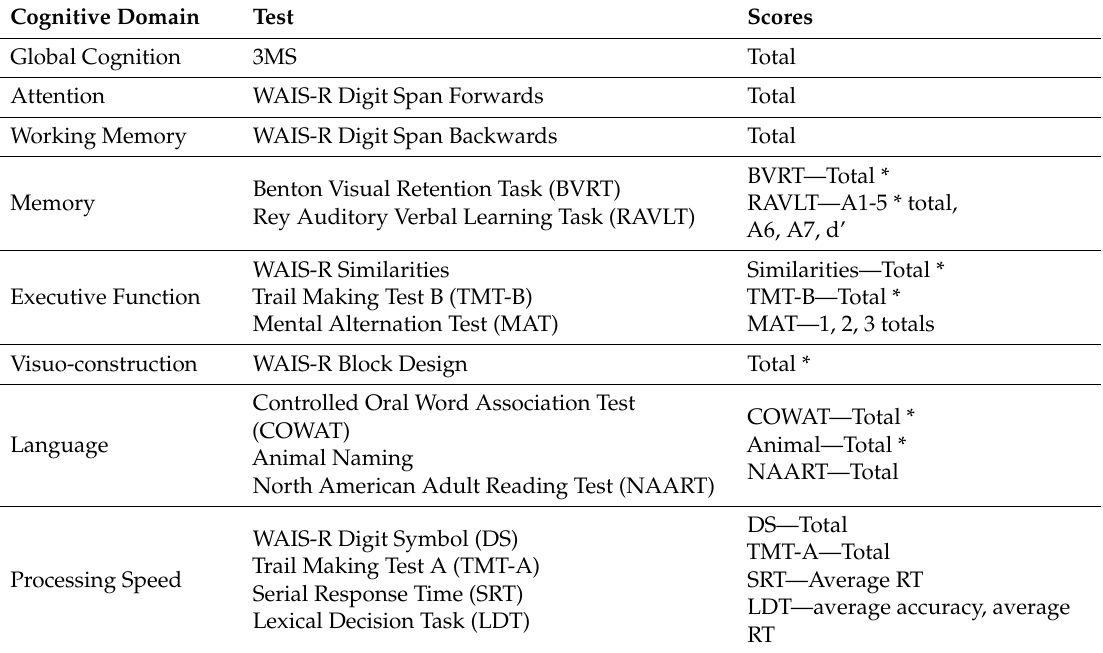
Table 2. List of Neuropsychological and Cognitive